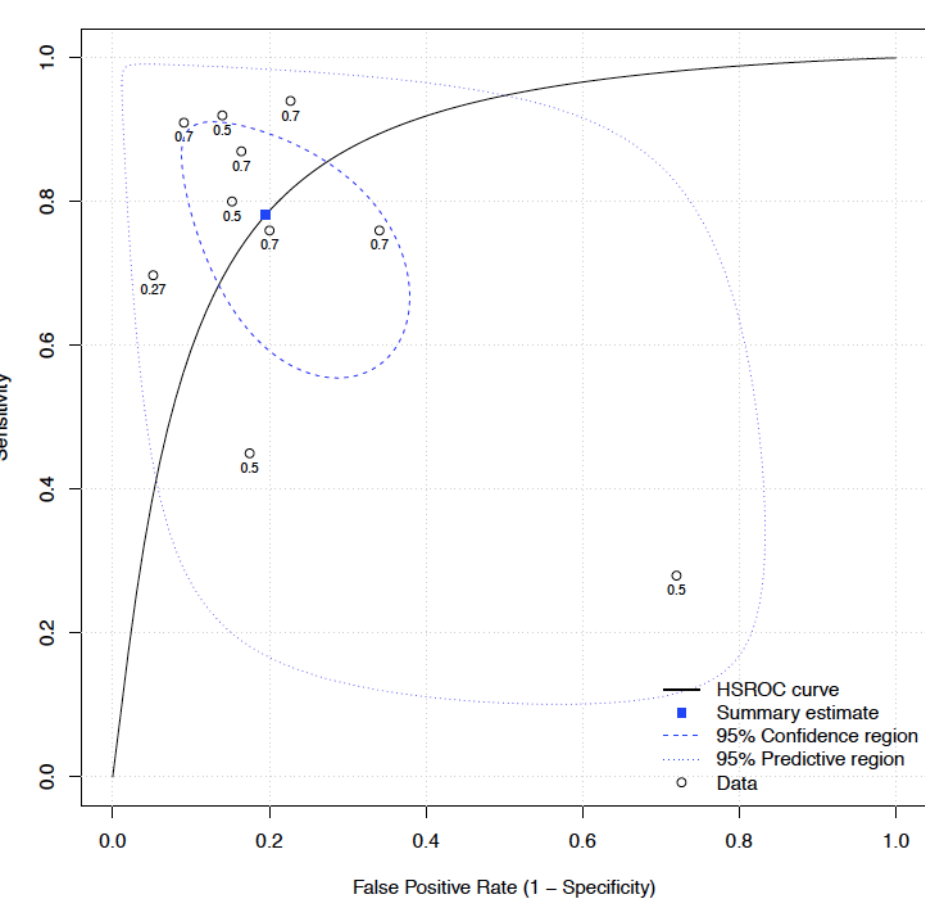
Figure 3. Random effects meta-analysis of intraoperative adverse events machine learning algorithms. HSROC: hierarchical summary receiver operating characteristics.